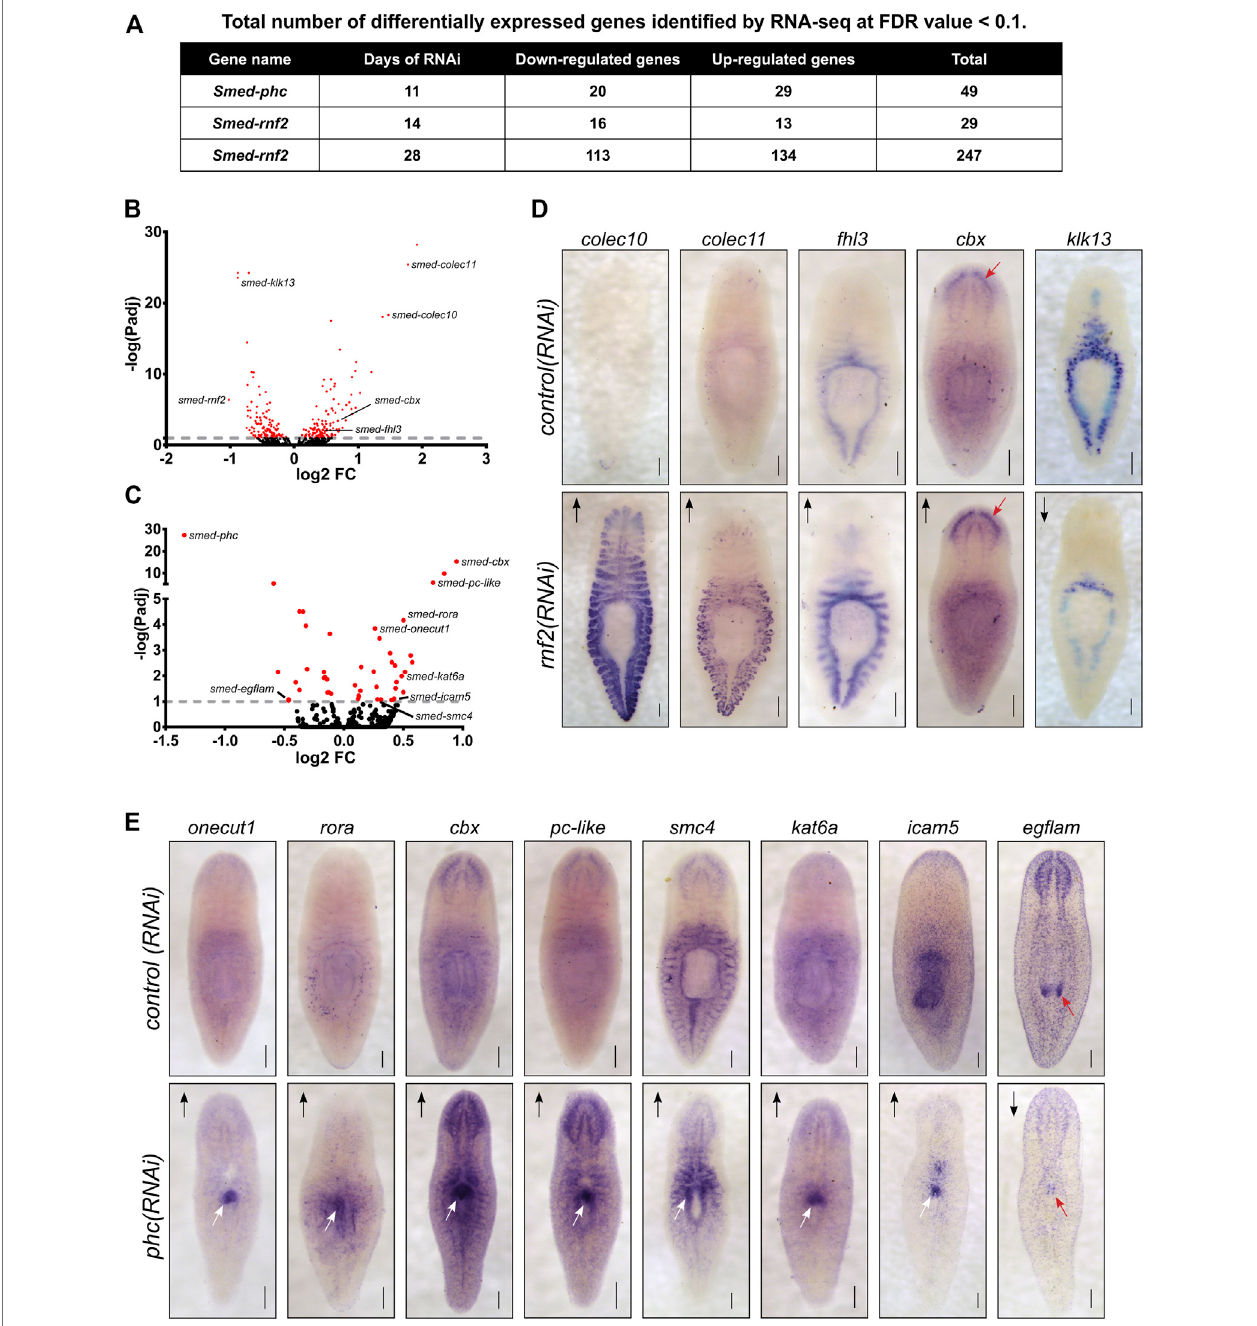
FIGURE 7 | Loss of PRC1 function causes changes to gene expression levels and spatial patterning. (A) Summary of the total number of differentially expressed genes detected following RNAi knockdowns. (B) Volcano plot of differentially expressed genes after 28 days of rnf2 RNAi treatment. (C) Volcano plot of differentially expressed genesafter28 daysof phc RNAi. (D) WISHanalysisofselectgenesthatweredifferentiallyexpressedbyfollowing rnf2 RNAi(N (cid:1) 6 – 12animalspergroup). (E) WISH analysis of selected genes indicated to be differentially expressed after phc RNAi knockdown (N (cid:1) 6 – 10 animals per group). The length of time each probe was developed was equal between target RNAi and control RNAi samples. Arrows indicate up- or down-regulated expression measured by RNA-seq. Red arrows highlightregionswithchangedexpressionafterRNAiintheworm ’ sbrain (D) andmouth (E) regions.WhitearrowsindicateregionsofectopicgeneexpressionafterRNAi treatment. Scale bars (cid:1) 200 μ